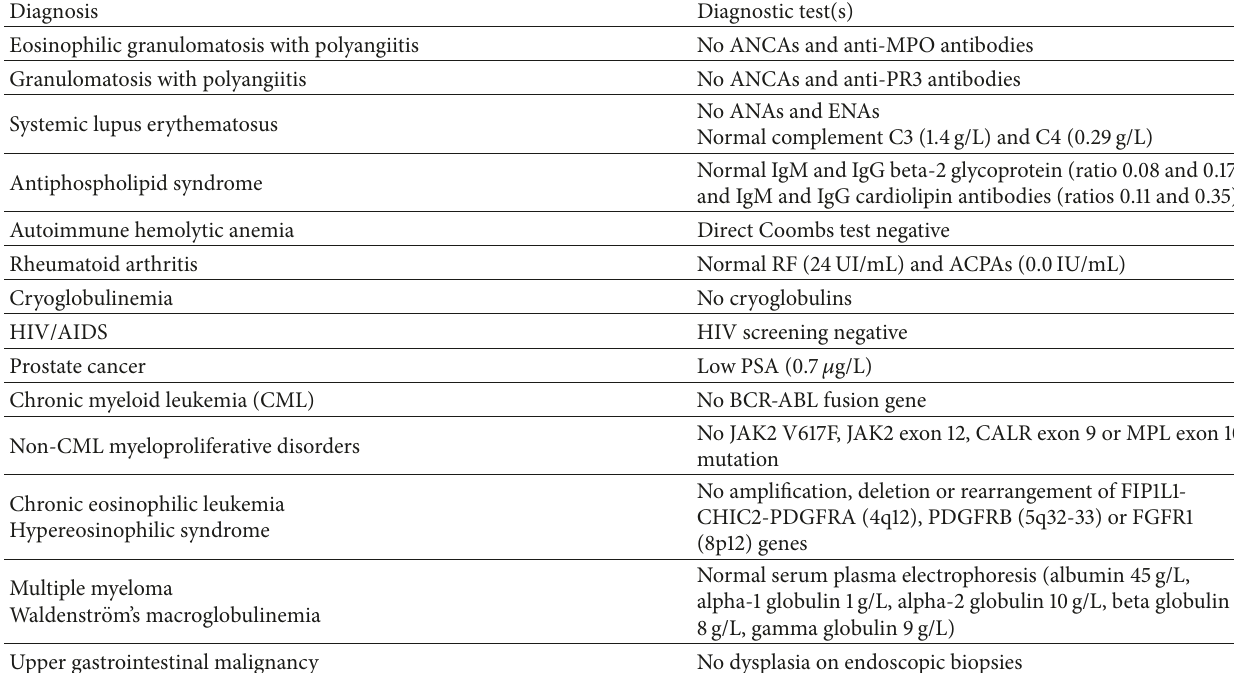
Table 1: Differential diagnostic considerations and results of corresponding diagnostic